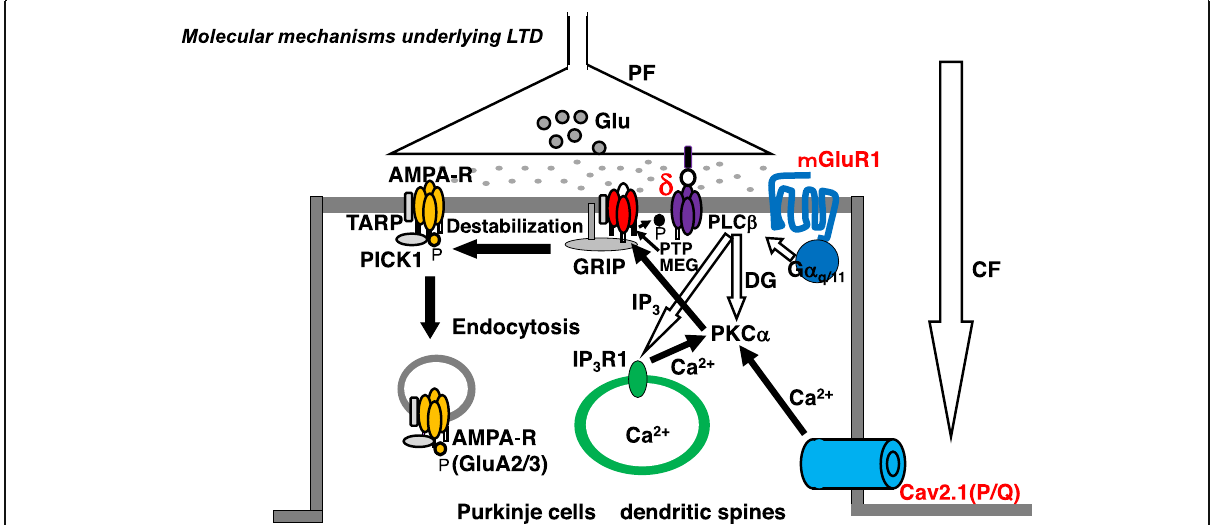
Fig. 2 Schematic diagram of long-term depression (LTD) at excitatory synapses between parallel fibers and Purkinje cells. The climbing fiber input elicits complex spikes through the activation of dendritic P/Q type Ca 2+ channels, leading to an increase in intracellular calcium concentration ([Ca 2+ ] i ). On the other hand, the parallel fiber input activates metabotropic glutamate receptor-PLC β -IP 3 signaling pathways, resulting in an increase in [Ca 2+ ] i. The conjunctive activation of these two pathways increases [Ca 2+ ] i more than the additive level. The high [Ca 2+ ] i activates PKC α , and PKC α phosphorylates GluA2 of the AMPA ( α -Amino-3-hydroxy-5-methyl-4-isoxazolepropionic acid) receptor, which results in detachment of the AMPA receptor from scaffold proteins and its internalization with PICK1 in an AP2 and clathrin-dependent manner. CF; climbing fibers, PF; parallel fibers, Glu; glutamate; AMAPA-R; AMPA receptor, mGluR1; metabotropic glutamate receptor, Cav2.1 (P/Q); P/Q type Ca 2+ voltage-gated channel, PLC; phospholipase C, PKC; protein kinase C, IP 3 ; Inositol triphosphate, GRIP; Glutamate receptor interactive protein, TARP; transmembrane AMPA receptor regulatory proteins, PICK1; protein interacting with C kinase, δ ; GluR delta 2, PTPMEG; megakaryocyte protein